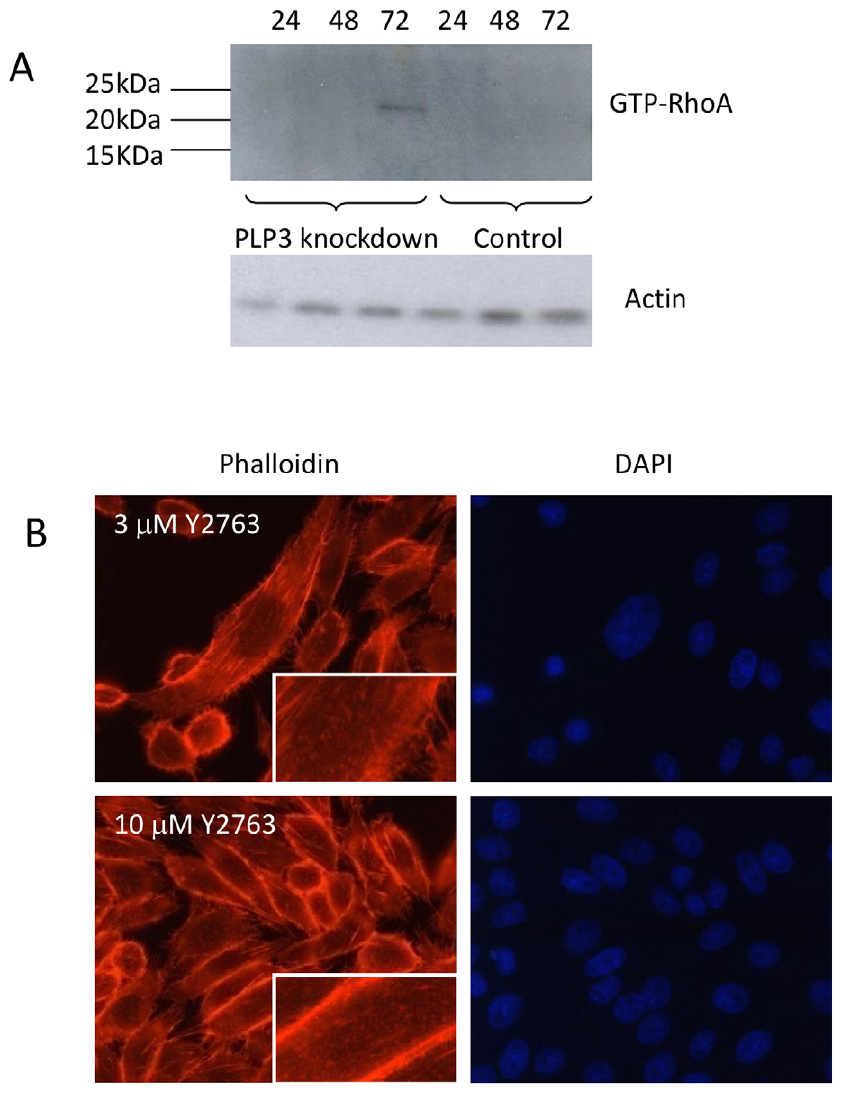
Figure 4. RhoA/p160ROCK pathway regulates actin stress fiber formation in PhLP3 siRNA silenced CHO LB01 cells. A commercially available RhoA-GTP/Rhotekin pull down assay was carried out on siRNA silenced PhLP3 LB01 cells. Samples were collected 24 h, 48 h and 72 h post transfection and activated RhoA was detected at 72 h post-knockdown with an anti-Rho A antibody but not in plasmid only control cells (A). LB01 cells transfected as in panel A for 72 h were then treated for 24 h with the ROCK inhibitor Y2763 (either 3 m M or 10 m M), fixed and stained for actin (rhodamine phalloidin, red). F-actin disassembly was observed at both Y2763 concentrations and the concentration of peripheral actin was observed with 10 m M Y2763